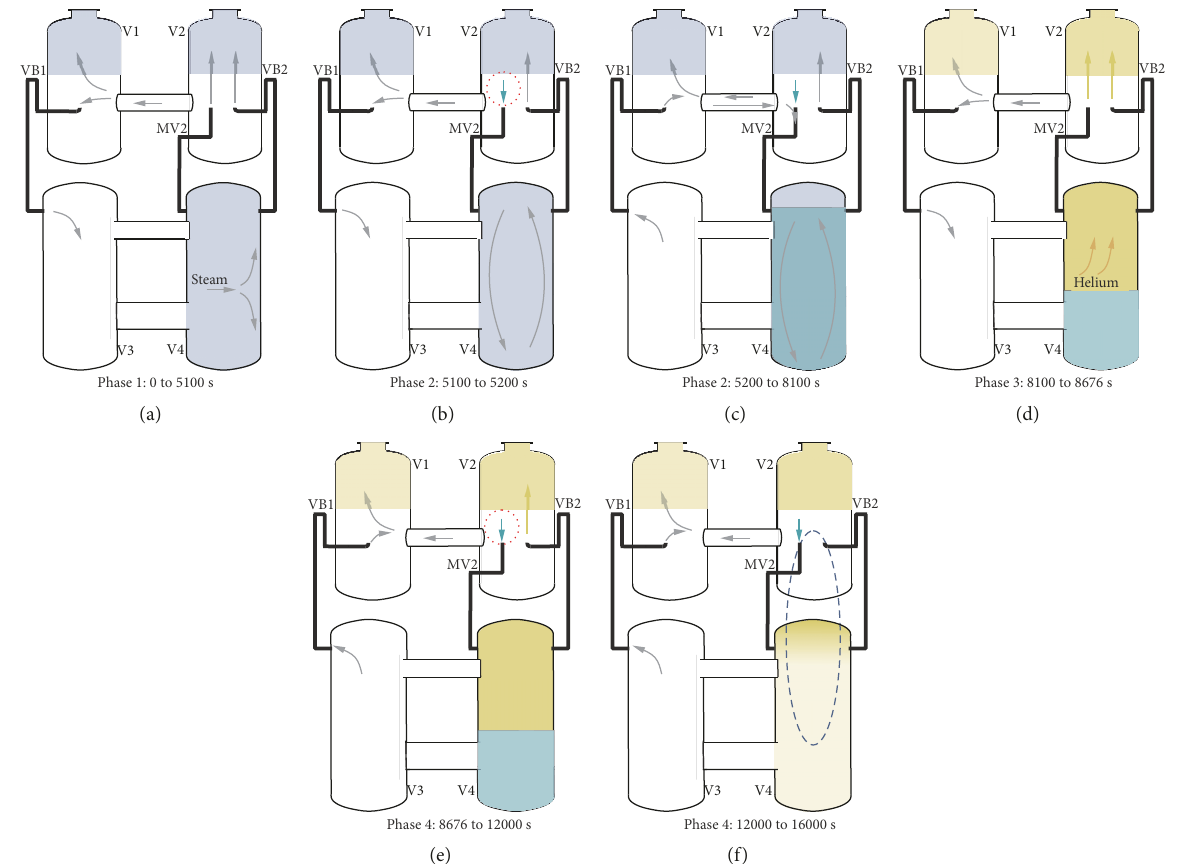
Figure 10: Global flow structures and phenomena in all four vessels during all phases of the experiment HP6 2.